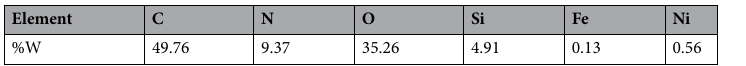
Table 1. The percentages of each element in EDS analysis.